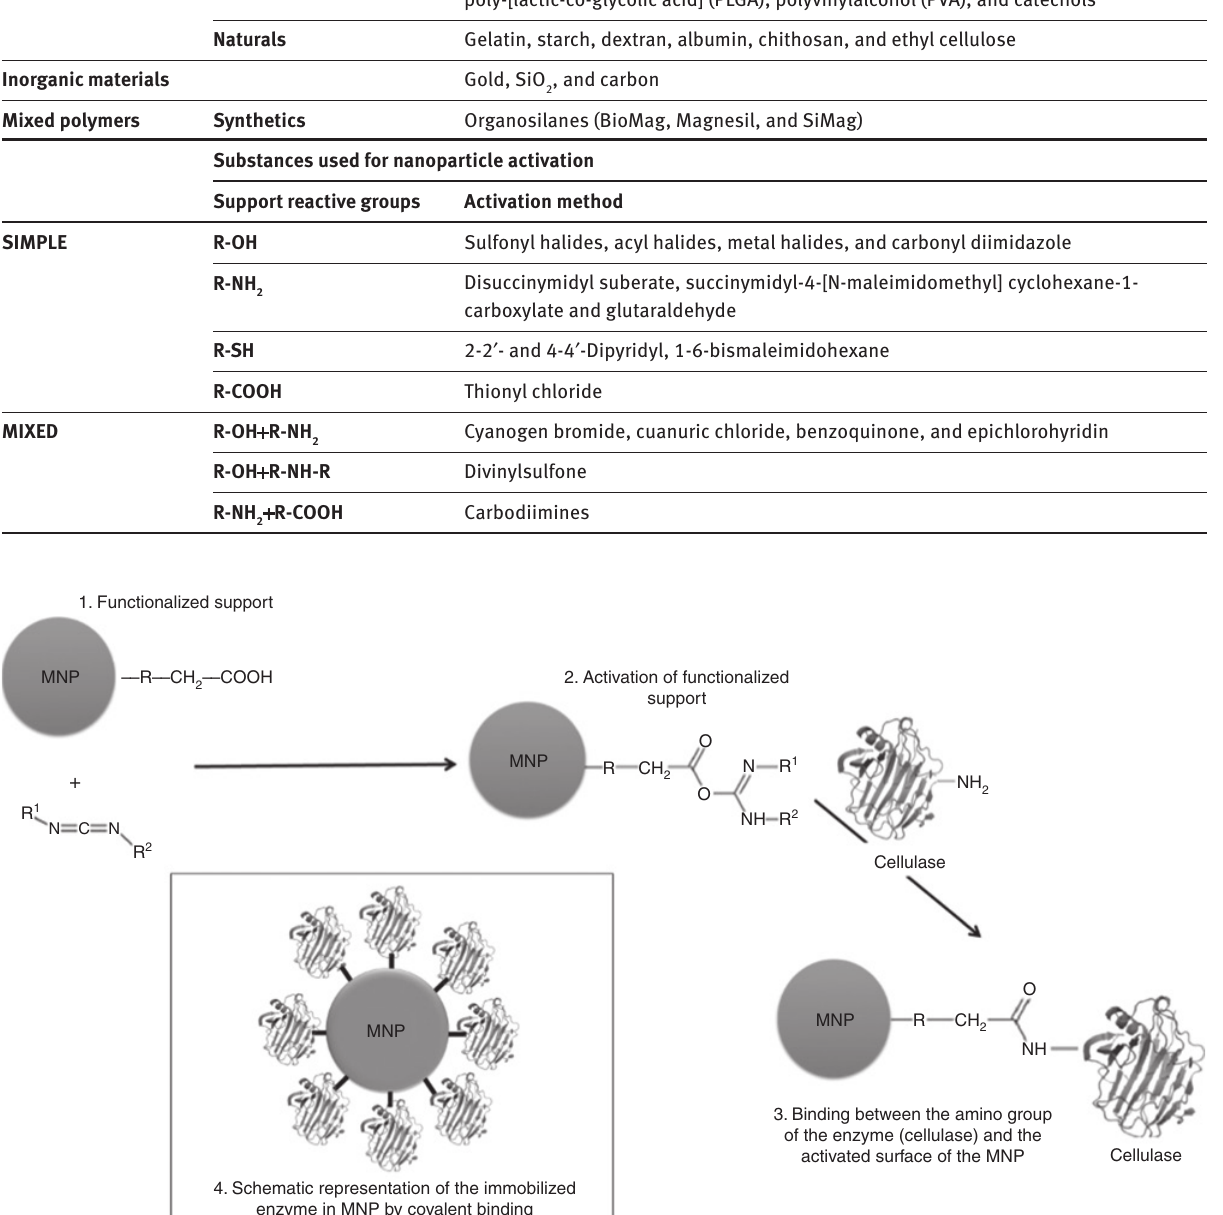
Table 1: Surfactants, polymers and other functional materials and the activating agents used in the preparation of nanoparticles [73, 78–85]. Substances used for nanoparticle functionalization